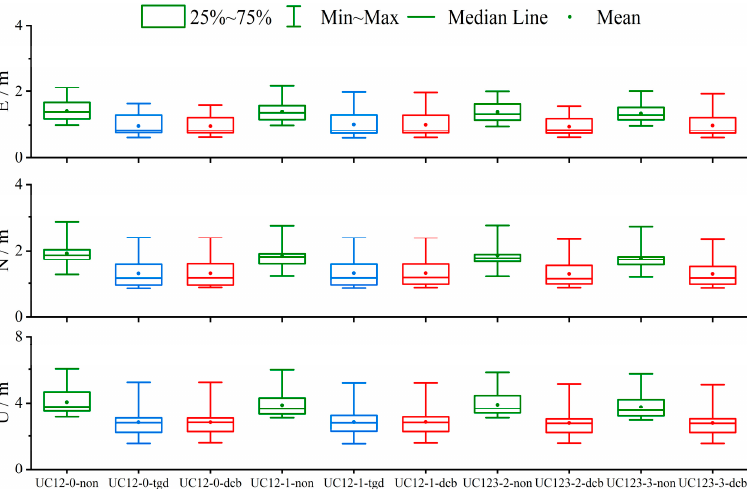
Figure 7. Box plot of UC123 SPP positioning accuracy.